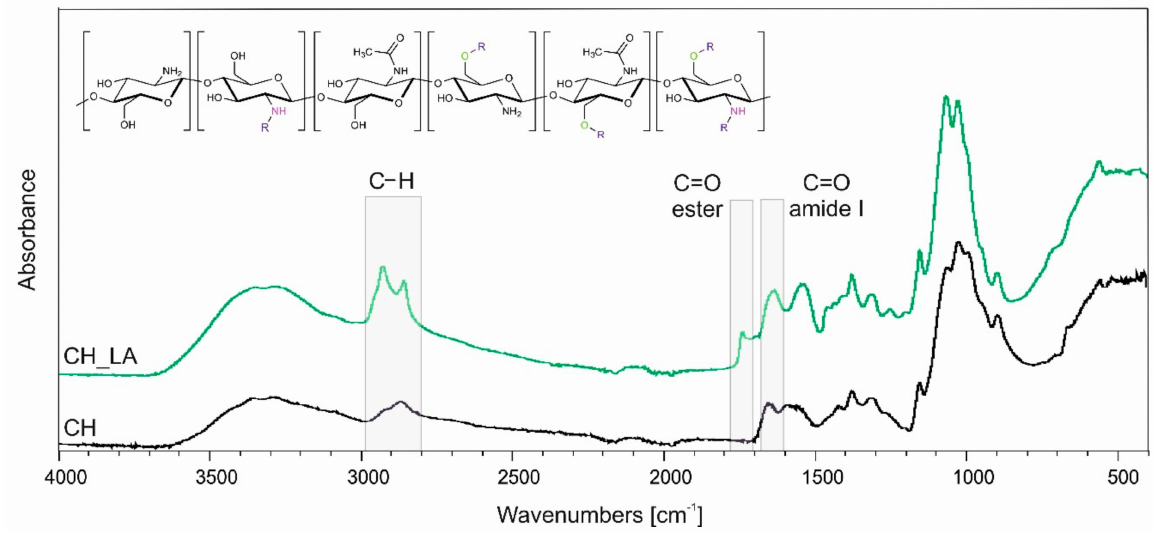
Figure 1. Infrared spectra of chitosan (CH) and chitosan with linoleic acid (CH_LA) and chemical